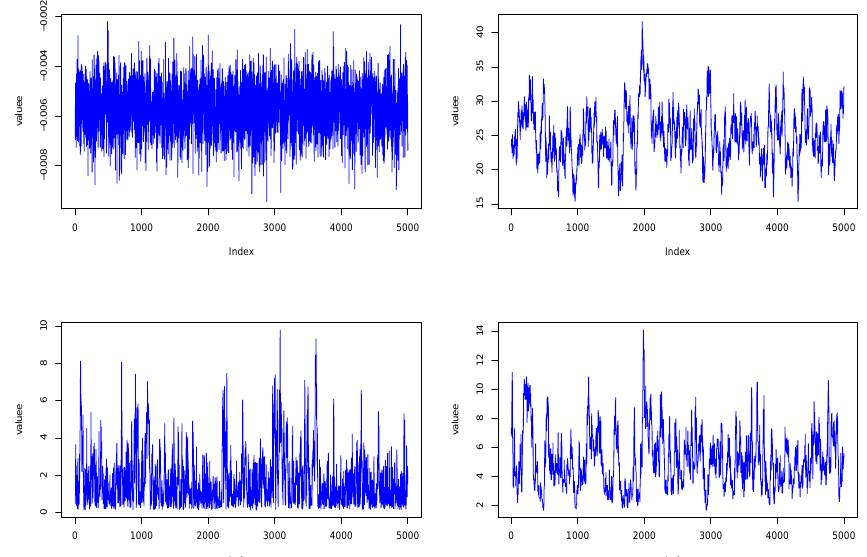
Figure A1. ( upper left ) Trace plot for β ; ( upper right ) Trace plot for φ ; ( lower left ) Trace plot for σ 2 ; ( lower right ) Trace plot for σ 2 w